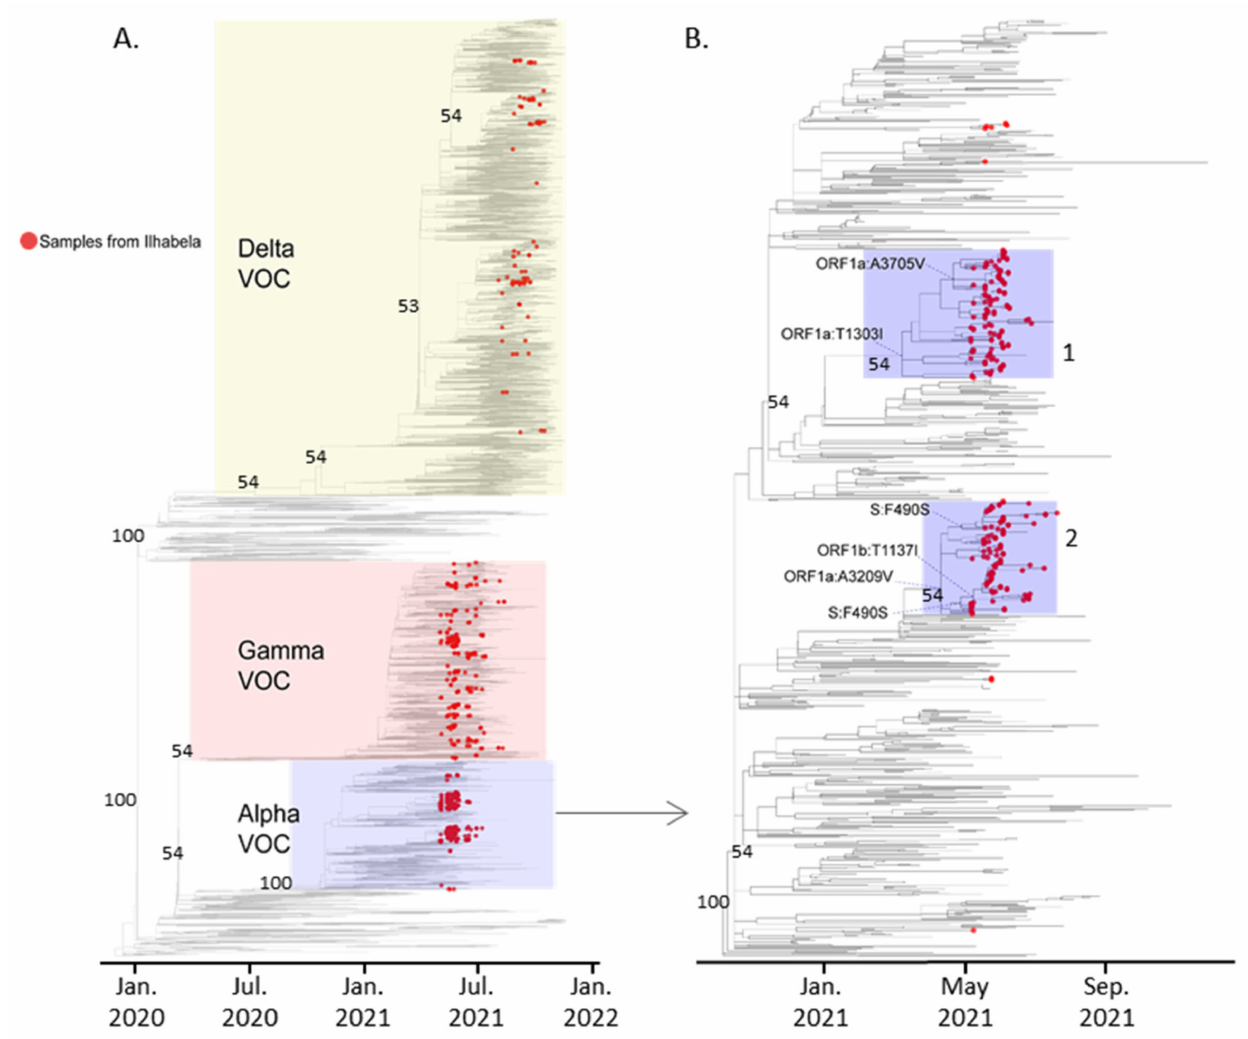
Figure 2. Maximum Likelihood time-tree of SARS-CoV-2 genomes of Ilhabela (red tips) inferred to a dataset with reference Alpha, Gamma and Delta VOC genomes obtained in Brazil and worldwide, downloaded from GISAID. Bootstrap values are presented for major branches. ( A ). Full dataset phylogeny with VOC clusters highlighted: Delta (light yellow background), Gamma (light pink background) and Alpha (light blue background). ( B ). Zoom in the Alpha branch showing the two monophyletic clustering of Ilhabela samples and their defining